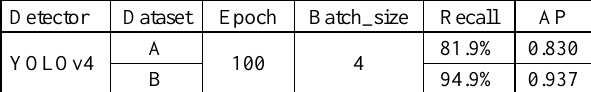
Table 1 . Comparison of recall and AP of dataset A and B respectively detected by